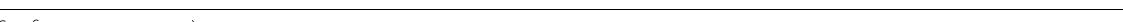
figure on next Fig. 6 The invasive ability of B. cinerea is positively correlated with the activation of the peroxisome pathway. a B. cinerea hyphae in onion epidermal cells at 12 hpi after stained with trypan blue. Bar 100 μm. b Scatter plot showing the percentage of invasive hyphae in a . The different letters (a, b, = and c) indicate significant differences at the level of P <0.01. c Fluorescence produced by strain GFP-SKL on onion epidermal layers. Bar 50 μm. d , e = Column charts showing hyphal length and peroxisome number. In b, d, and e , the values represent the average values, and the error bars indicate the standard deviations of 20 images in one experiment. f Relative expression levels of 6 DEGs annotated to the peroxisome pathway. The onion epidermal cells or cellophane were inoculated with conidial droplets in 10 mM glucose, and then collected at the indicated times for RT-qPCR analysis. The Y-axis represents the log2 value of the relative expression level. The expression level of each gene in conidia was set as ‘1’ and used as sample control. BcTubulin was used as an endogenous control. The values represent the average values, and the error bars indicate the standard deviations of 3 technical replicates in one experiment. All experiments were repeated three times with consistent